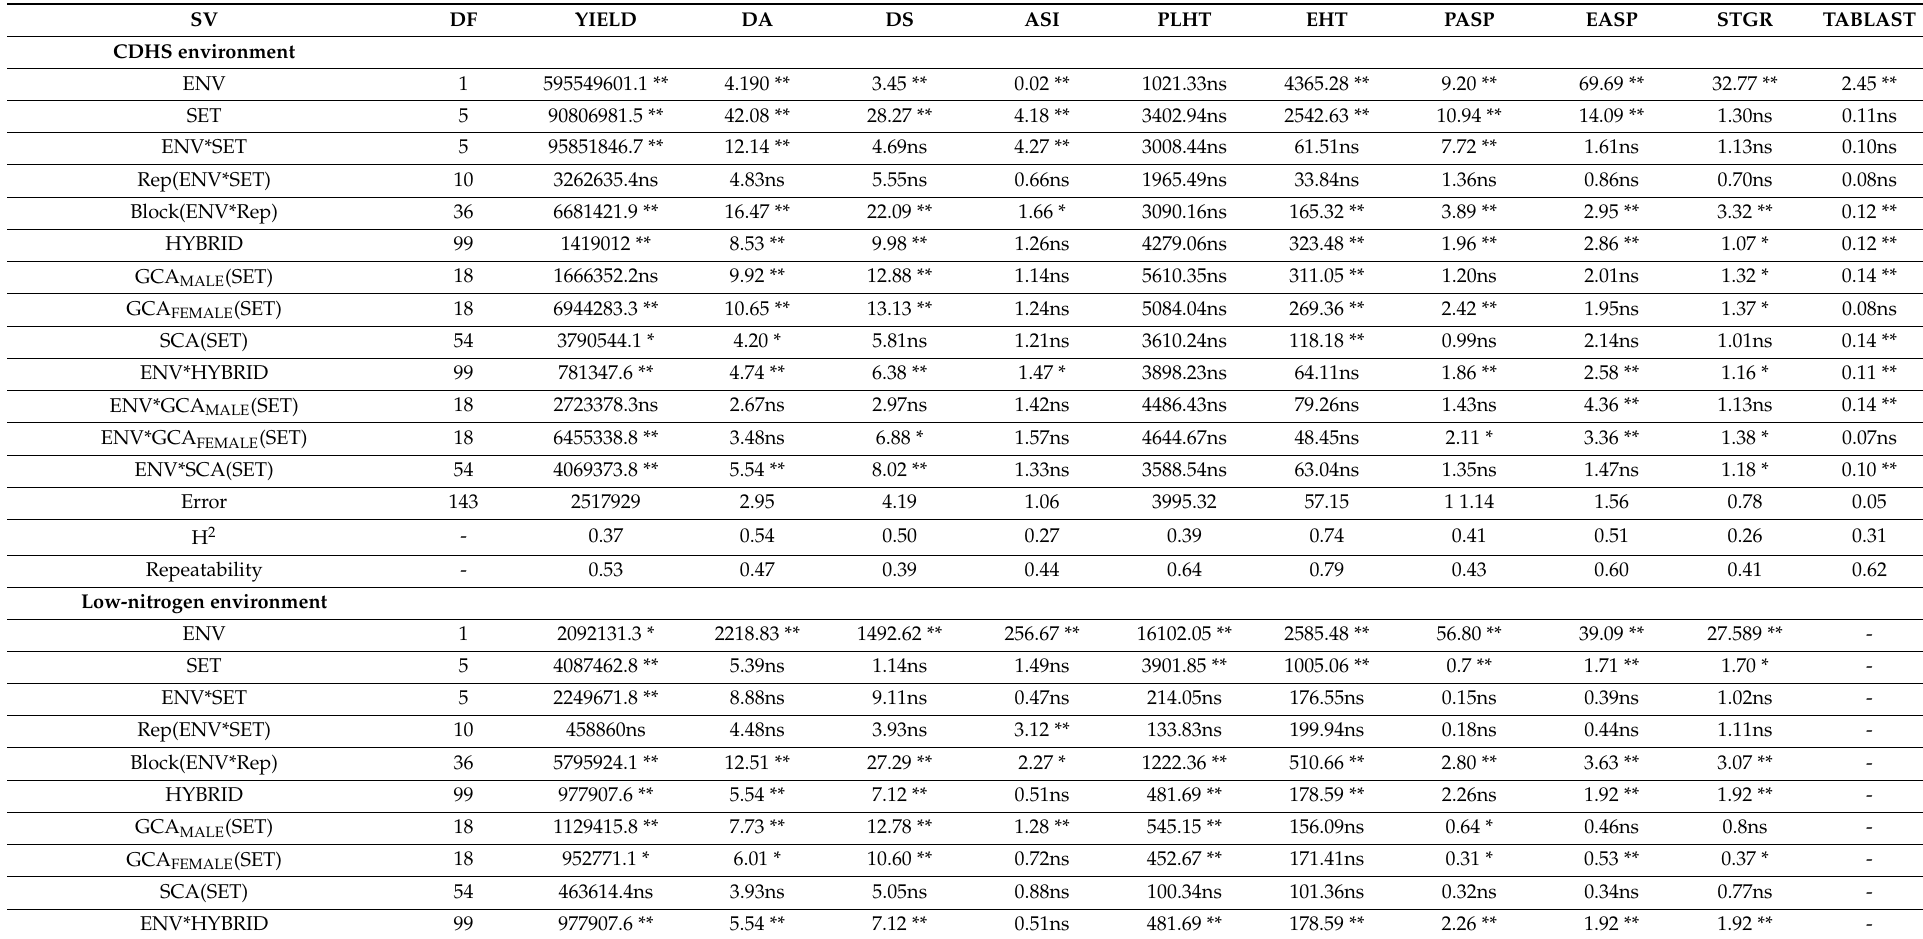
Table 1. Mean squares of grain yield and other agronomic traits of 96 early QPM hybrids evaluated under low-nitrogen conditions at Mokwa 2019 and 2020 growing seasons and under CDHS at Kadawa during the 2020 and 2021 dry